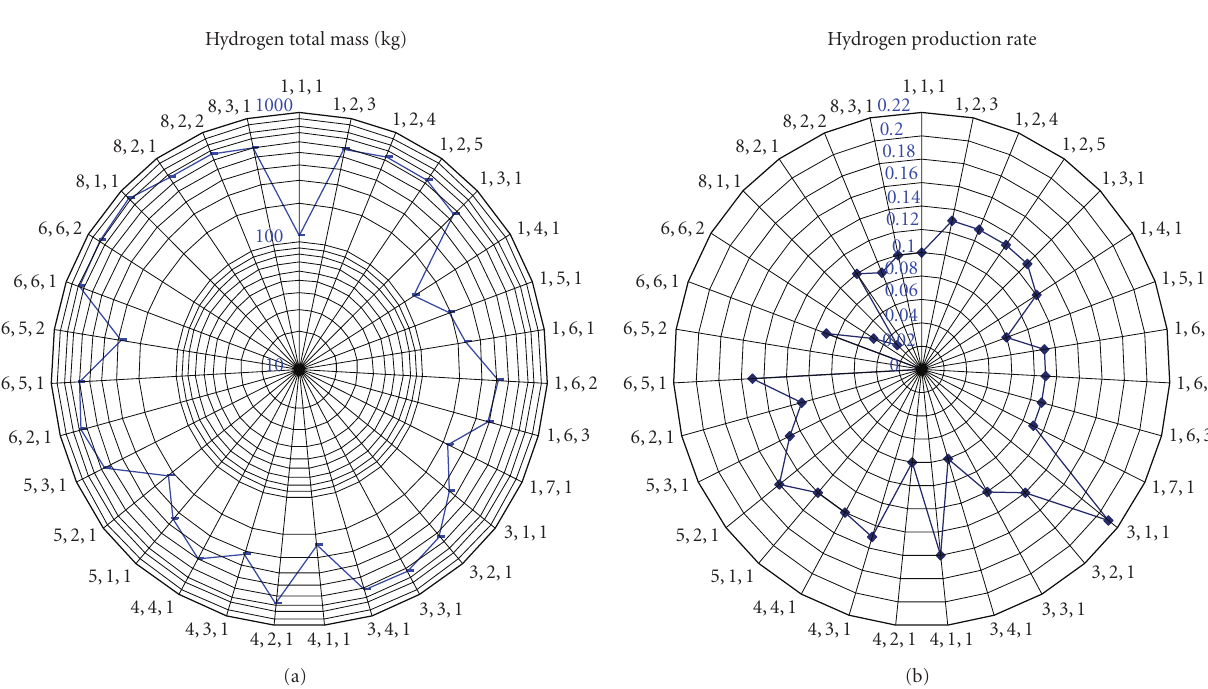
Figure 5: Hydrogen mass and hydrogen production rate for each core degradation